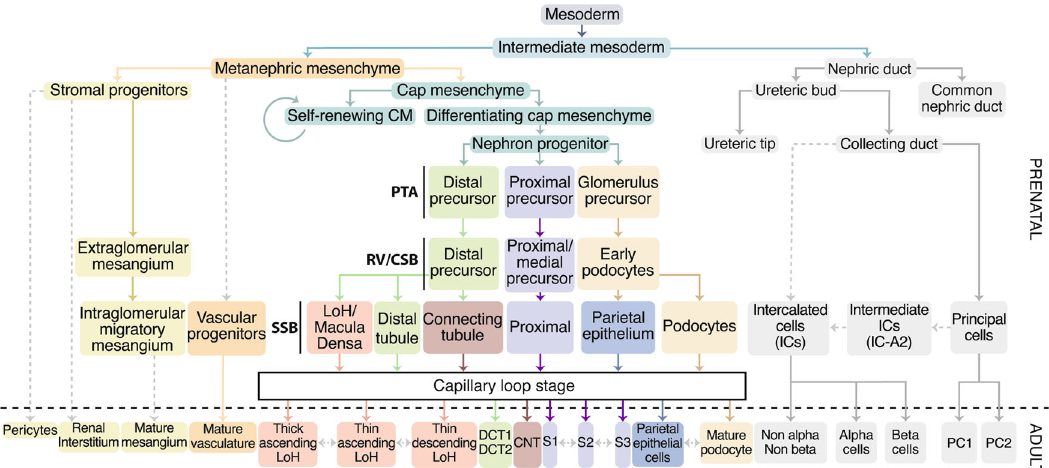
Fig. 2 Lineage tree of renal cell types in development based on non-scRNA sequencing and scRNA sequencing literature. Dotted arrows indicate possible lineage relationships, which are not fully proven or not highlighted in the discussed scRNA sequencing publications. Pretubular aggregate (PTA), renal vesicle (RV), comma-shaped body (CSB), S-shaped body (SSB), Loop of Henle (LoH), connecting tubule (CNT), distal convoluted tubule 1 and 2 (DCT1/2), segment 1/2/3 (S1/S2/S3), intercalated cells (ICs), principal cells